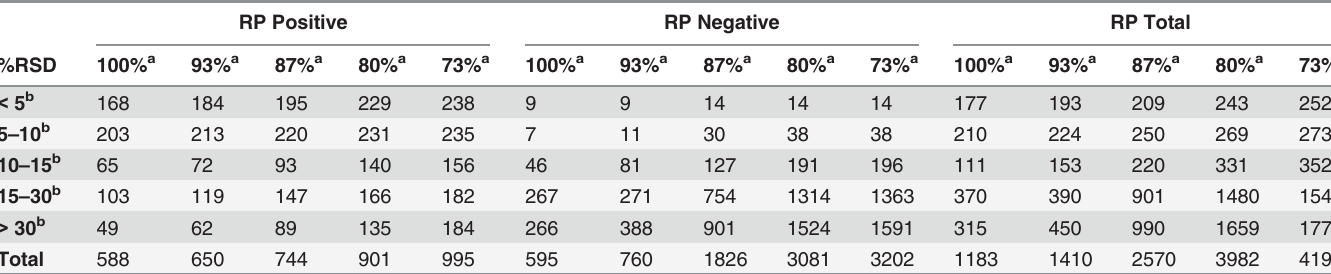
Table 4. Measured metabolite features in the reversed phase method in experiment